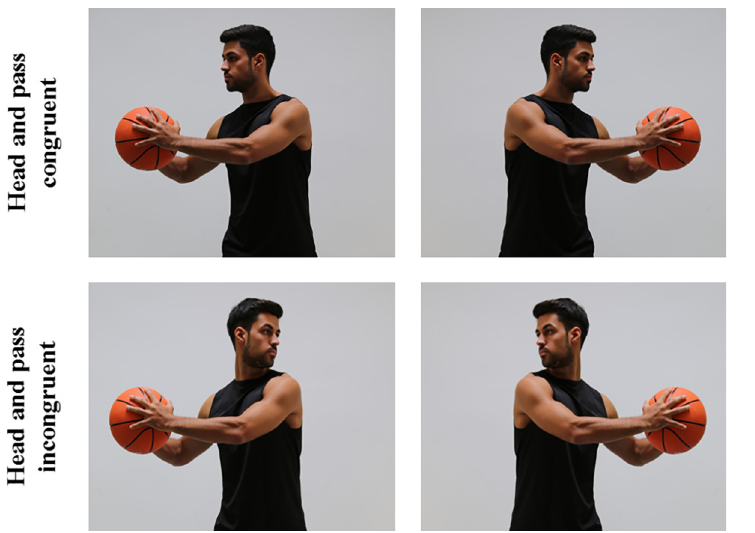
Fig 1. The four different targets used in the experiment.